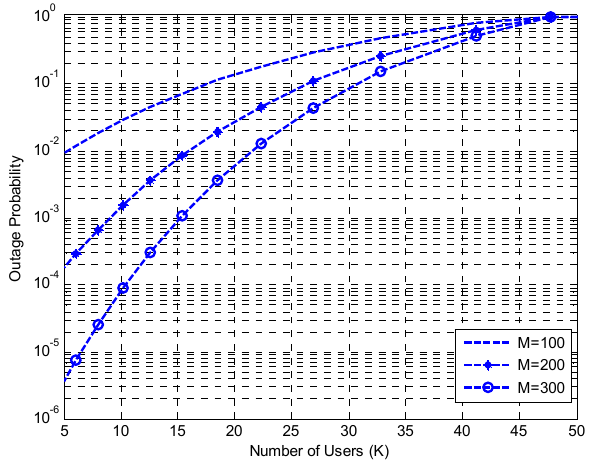
Figure 7. Outage Probability vs. number of users in multi ‐ cell system with L = 7, transmit power = 10 dB and (cid:0) ℓ th = 10 dB.